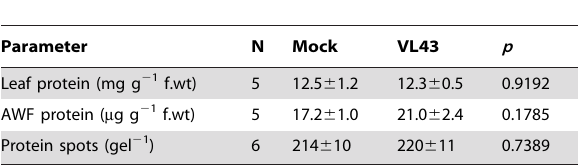
Table 3. Influence of Verticillium longisporum VL43 infection on protein content of whole leaf extracts, in apoplastic washing fluid and on the number of protein spots after 2-D